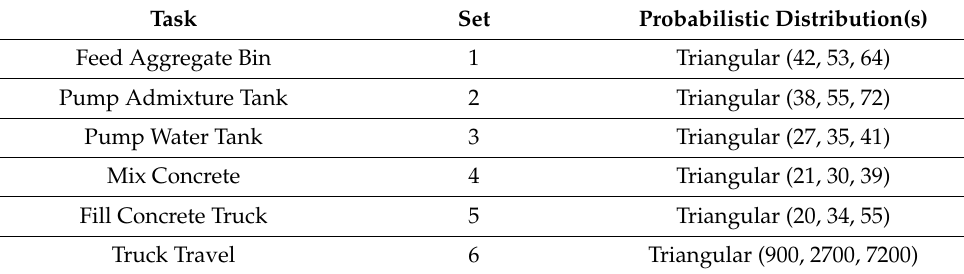
Table 2. Probability Distribution for Each Sub-Production